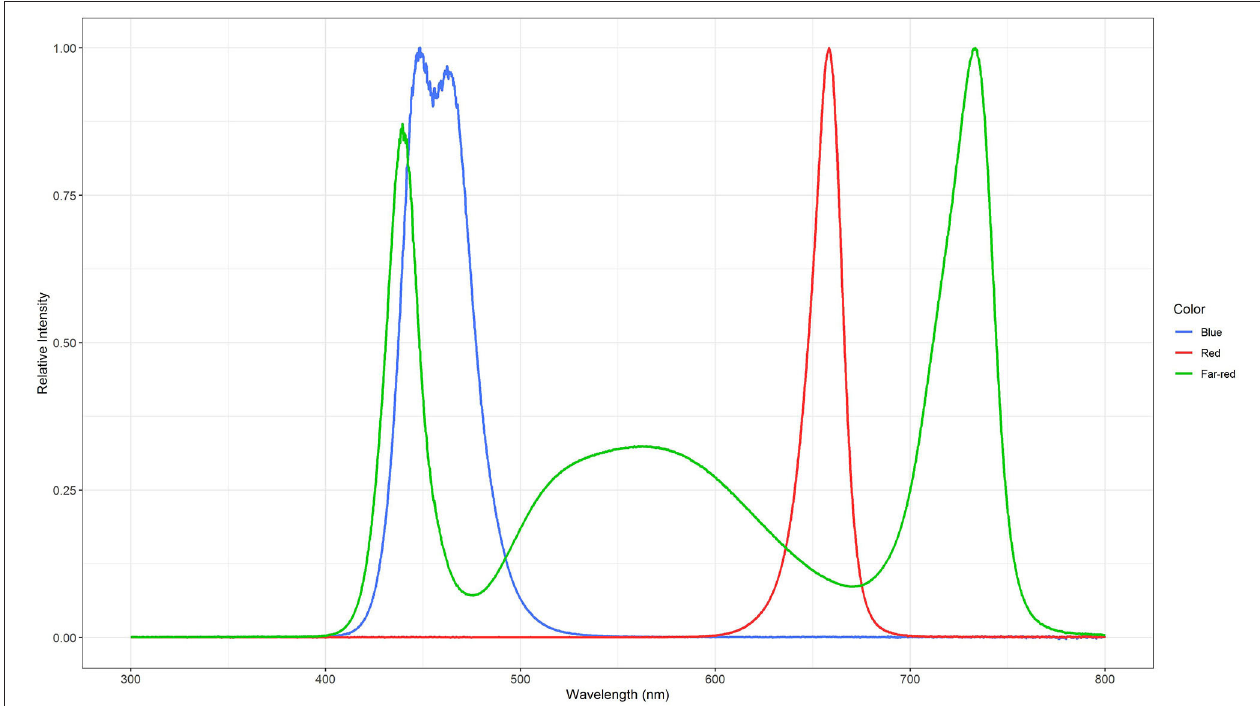
FIGURE 1 | Normalized spectral distributions of the blue (440 + 470nm), red (660nm), and far-red (730nm) light treatments. The far-red light treatment included white light (400–700nm) to ensure the same PPFD 700 in all treatments.